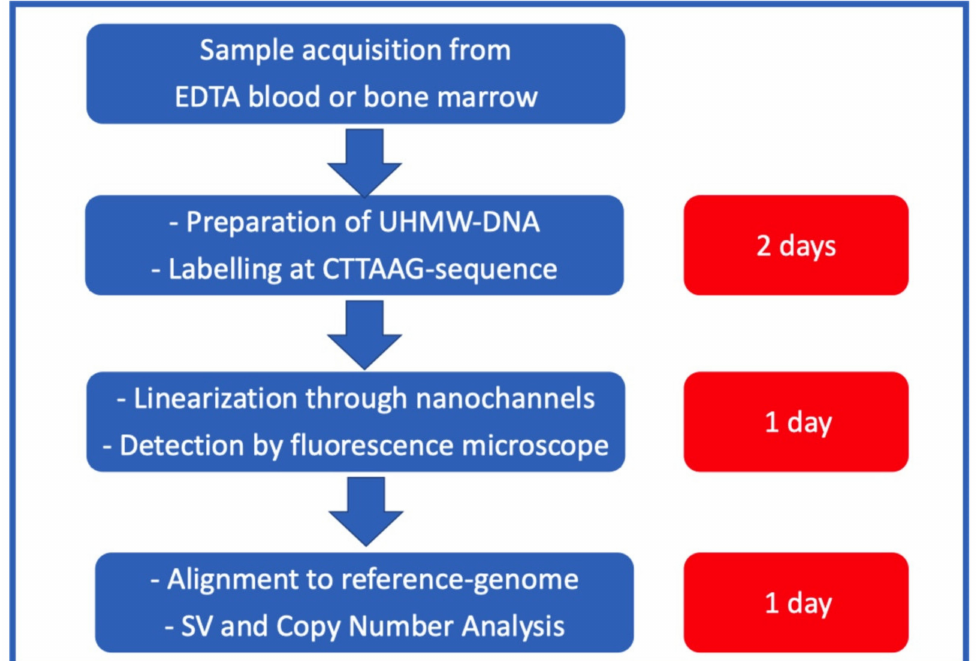
Figure 1. OGM workflow. After acquisition from blood or bone marrow, samples are either frozen or transferred to a lab. Ultra-high-molecular-weight (UMWH) DNA is prepared and labelled at CTTAAG sequence with a fluorochrome. The samples are transferred on a chip for linearization through nanochannels and run on a Bionano Saphyr ® system for detection by fluorescence microscopy. The genome is aligned according to a reference genome and analyzed through various algorithms with analysis of structural variants (SV) and according to copy number changes. Depicted timeline on the right shows minimum number of days required to analyze one